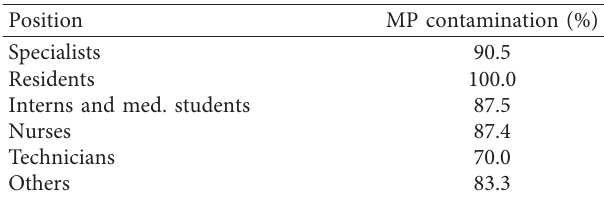
Table 6: Contamination distribution according to the position in the